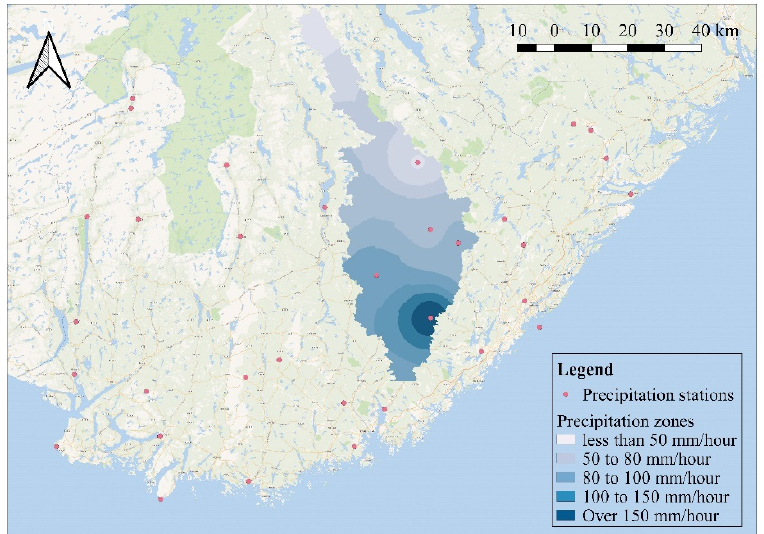
Figure 3. Spatial distribution of the precipitation stations and the interpolated precipitation over the catchment.